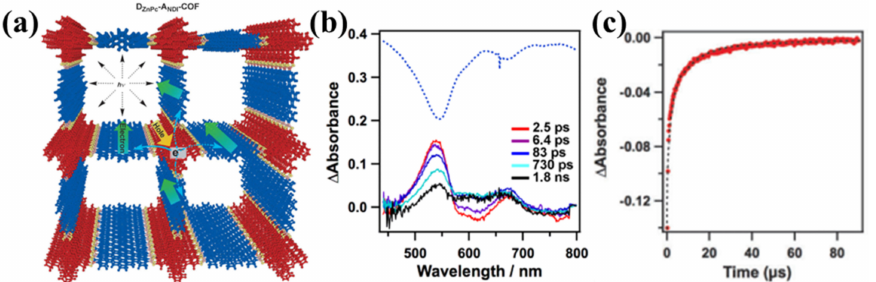
Figure 16. Illustration of a 2 × 2 cell of the 0.8 Å slipped AA-stacked COFs and photochemical events. ( b ) Femtosecond transient absorption spectra at an initial time of 1.4 ps. ( c ) The time profile of the nanosecond transient absorption band at 480 nm of a benzonitrile-dispersed COF suspension at 298 K (red dot). The lifetime of the charge-separated state was estimated to be 10 ms using curve-fitting (dotted black curve). Reproduced with permission from Ref. [60]. Copyright: Angewandte Chemie International Edition,